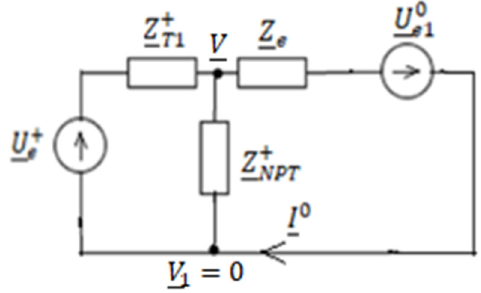
Figure 4. Equivalent scheme for the calculation of the zero-sequence current.